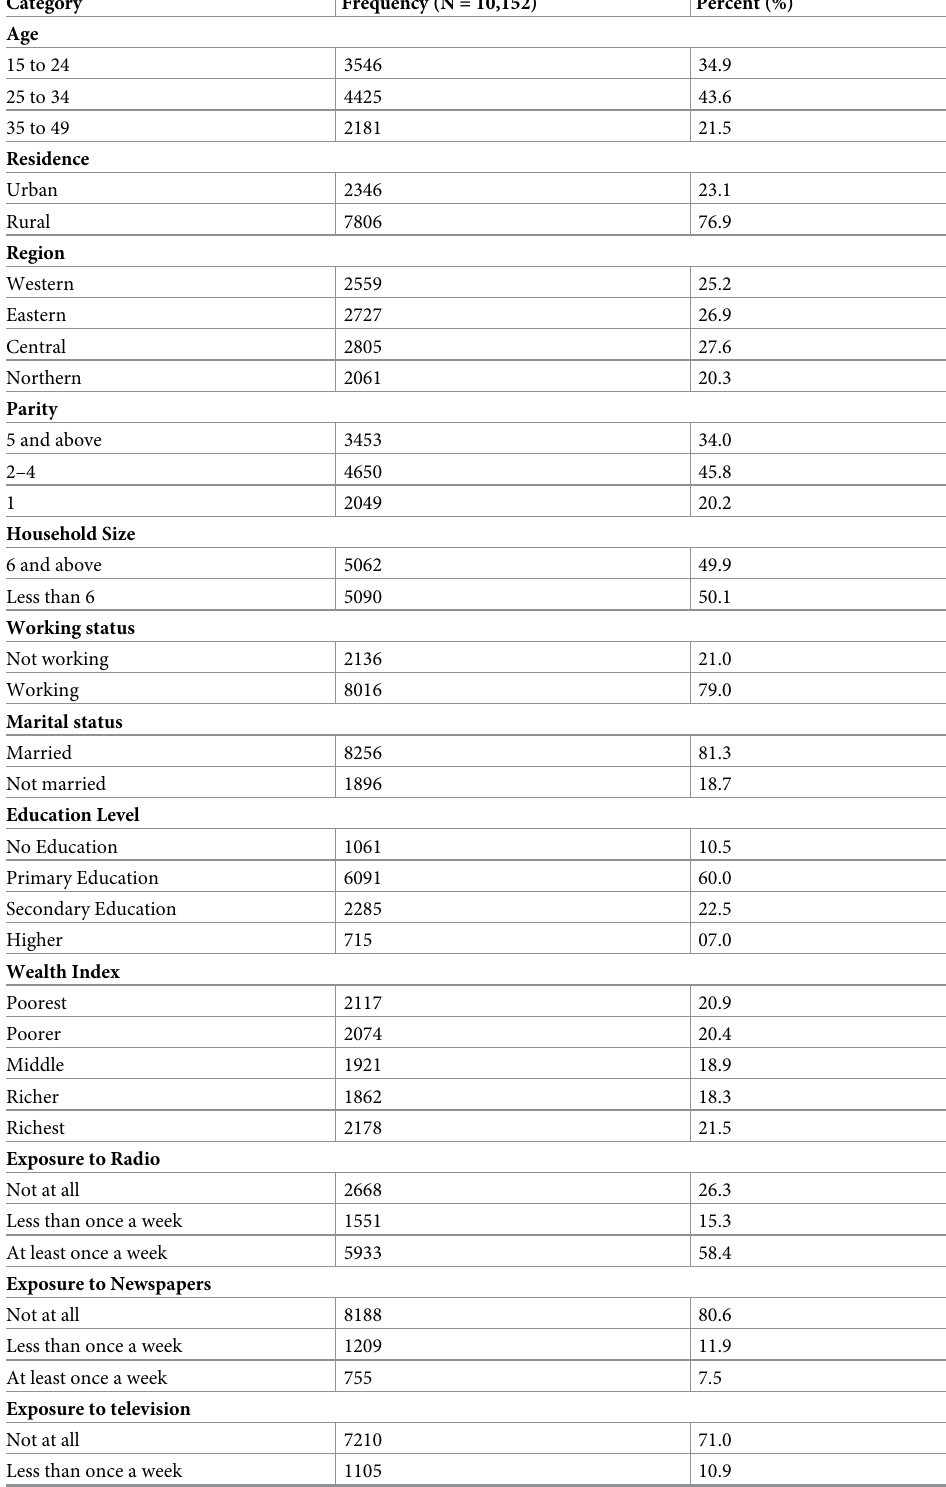
Table 1. Background characteristics of women who had given birth in the last 5 years as per the 2016